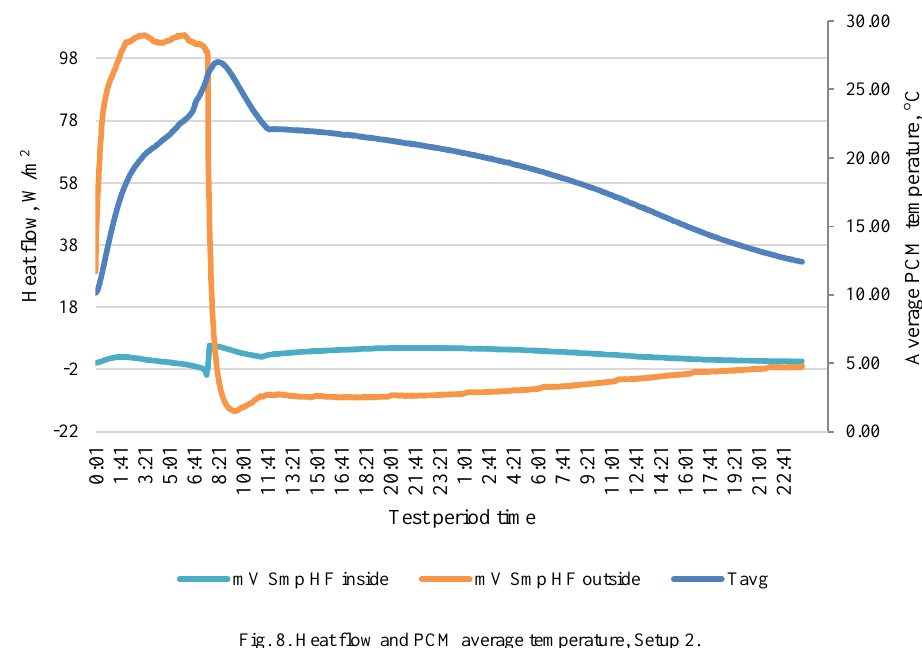
Fig. 8. Heat flow and PCM average temperature, Setup 2.